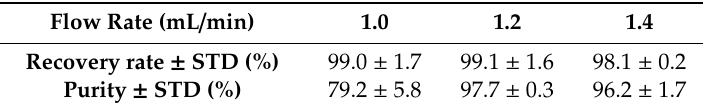
Table 1. The recovery rate and purity of 17 µm diameter beads at the circulating tumor cells (CTC) outlet at different flow rates. Experiments were carried out in triplicates and average recovery rates and purities were given with standard deviations (STD).